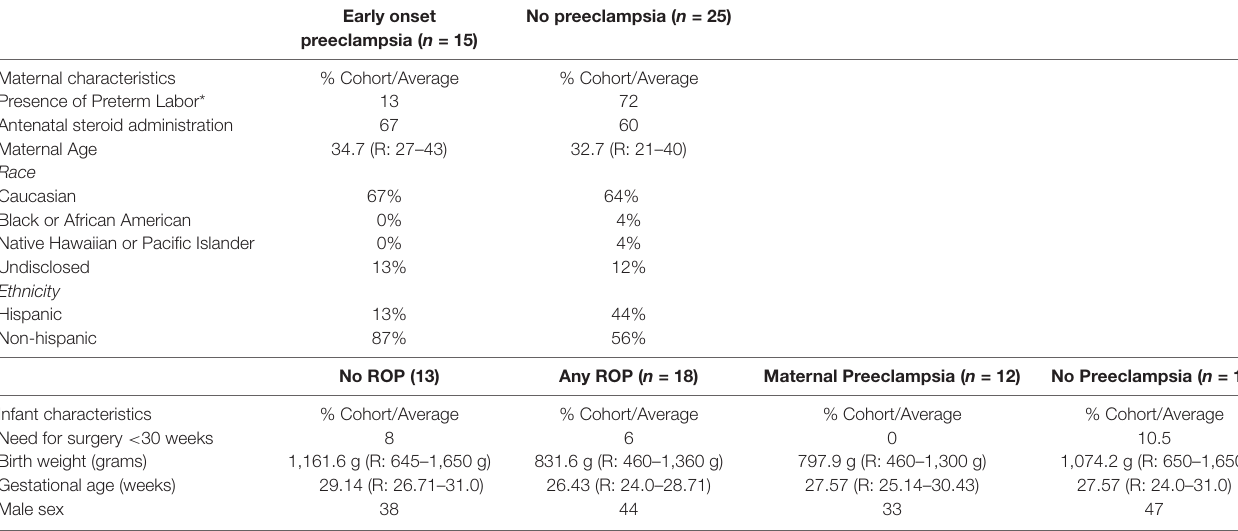
TABLE 1 | Discovery cohort clinical characteristics.